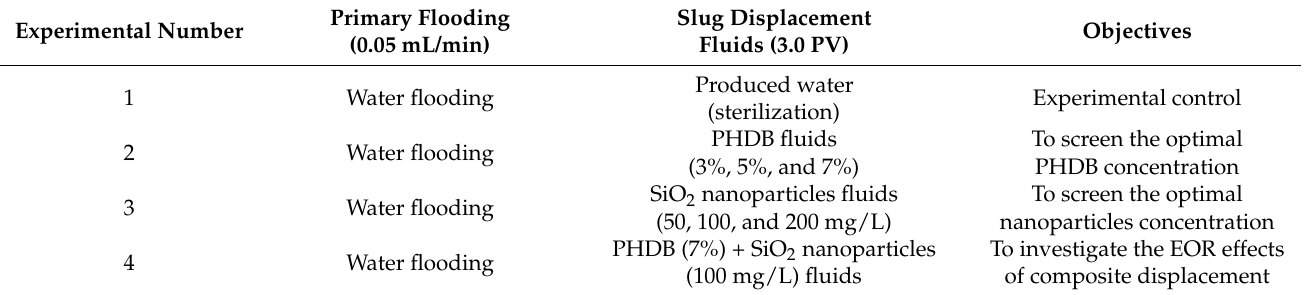
Table 1. Design of the micromodel displacement